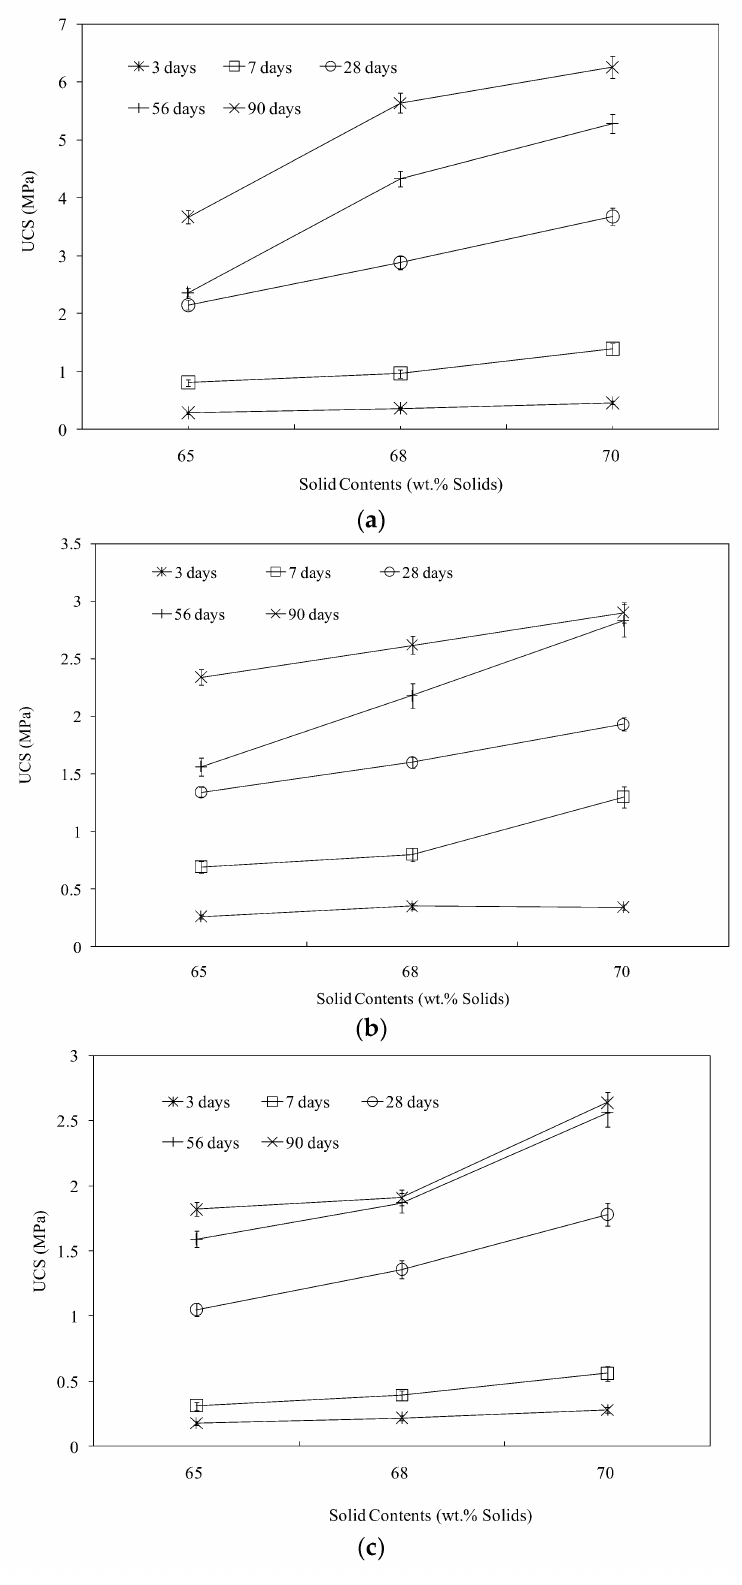
Figure 2. The effect of the solid content on the unconfined compressive strength (UCS) of cemented tailings backfill (CTB) samples with different binder content: ( a ) 25 wt %; ( b ) 16.7 wt %; ( c ) 12.5 wt